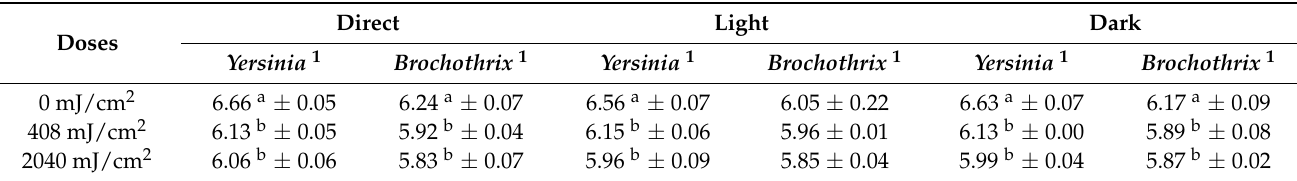
Table 3. LSM ± SE of Yersinia enterocolitica and Brochothrix thermosphacta counts on pork previously inoculated with these bacteria directly after treatments and after one hour of storage either in the light or in the dark to elucidate the effect of photoreactivation ( n =